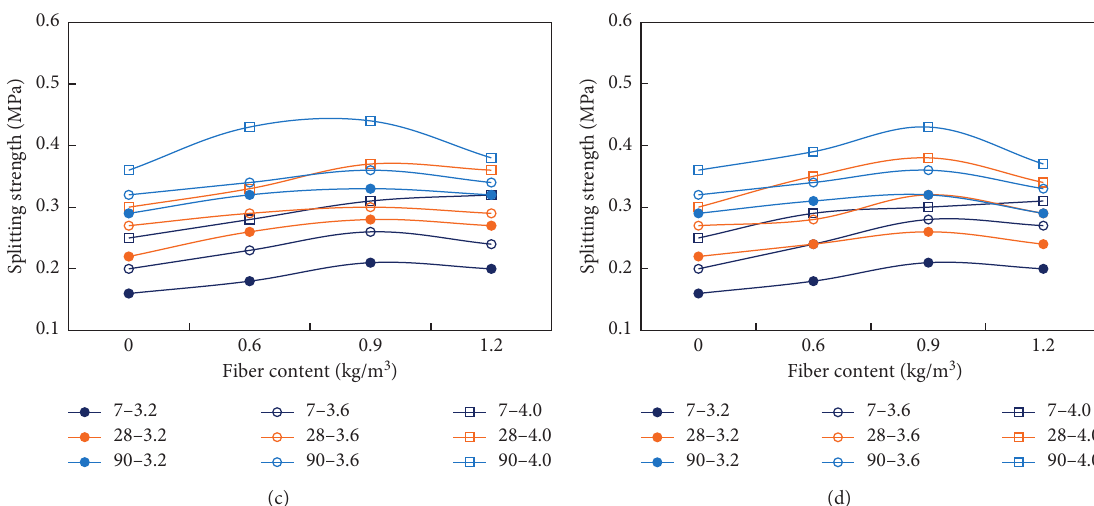
Figure 15: Trend chart of splitting strength of CSM: (a) fiber length of 12mm, (b) fiber of length 18mm, (c) fiber length of 24mm, and (d) fiber length of 30 mm.